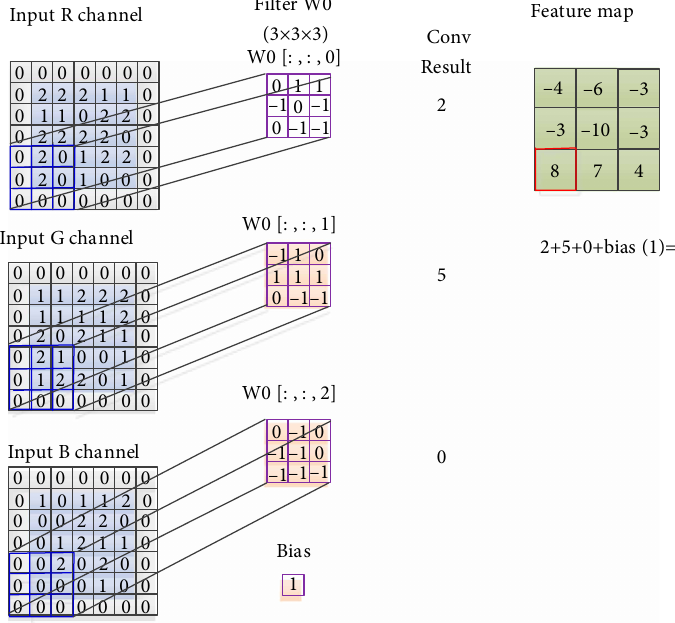
Figure 2: Convolutional operation on a RGB color image